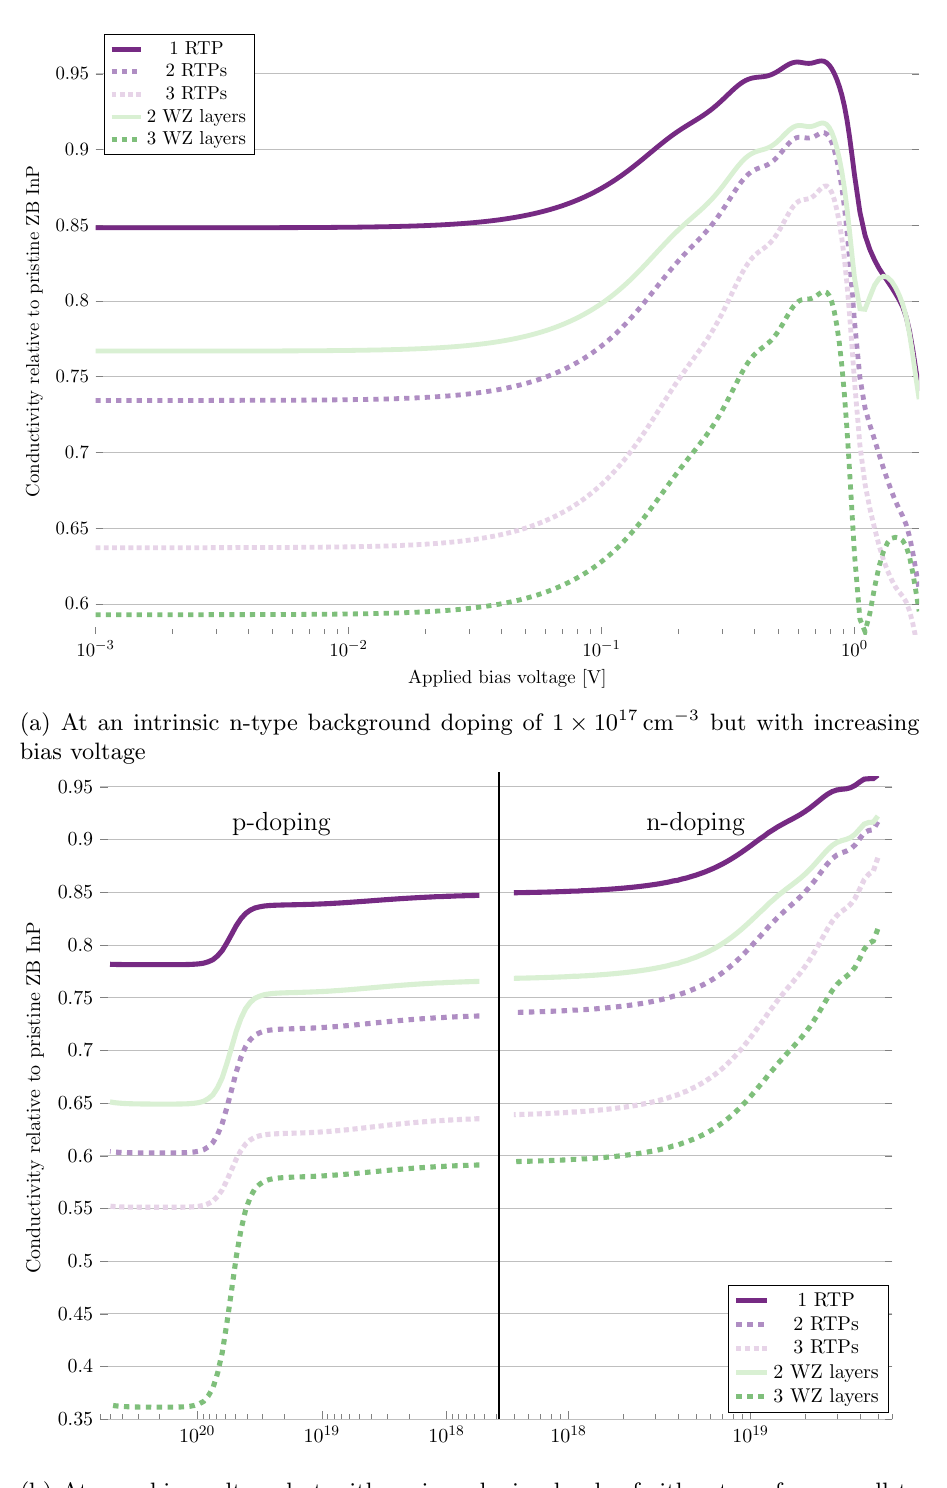
(b) At zero bias voltage but with various doping levels of either type from small to high doping levels. Figure 7. Differential conductivity of ZB InP with singular phase-defects along the [111]/[0001] crystallographic direction, relative to a pristine ZB